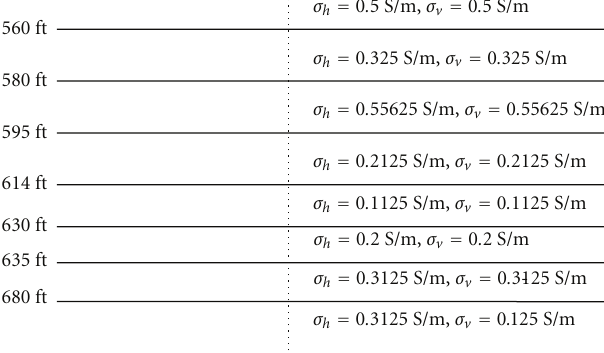
Figure 10: The eight-layer Devine test site formation.